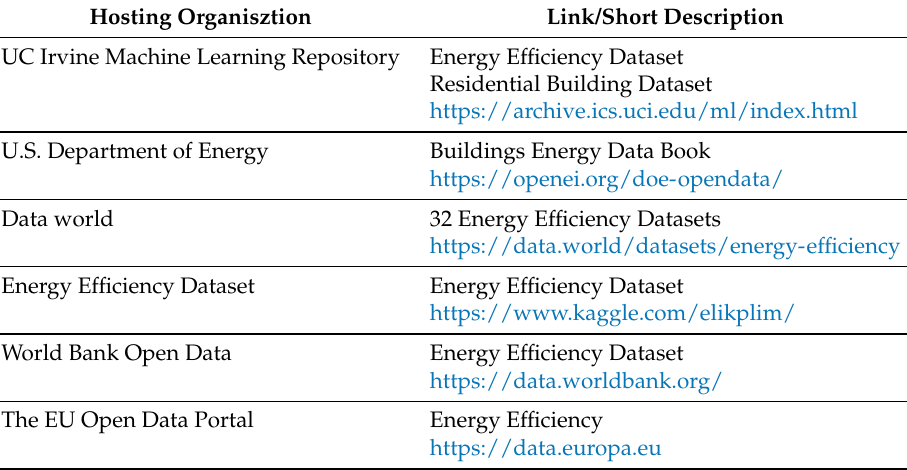
Table 7. Main sources of datasets analyzed during the